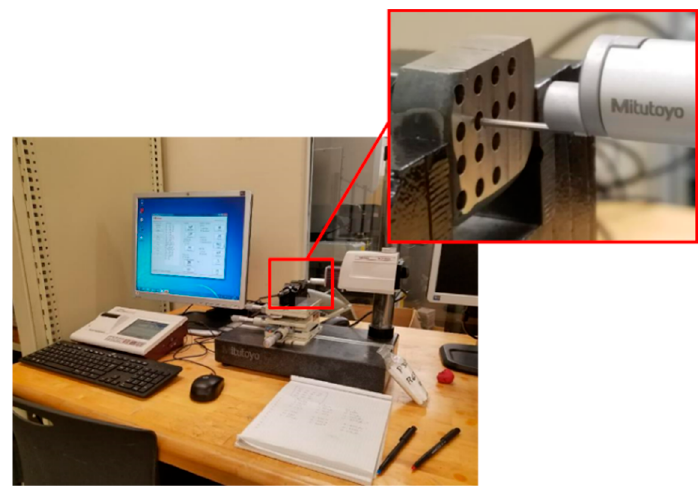
Figure 7. Mitutoyo profilometer and the setup for the roughness acquisitions.